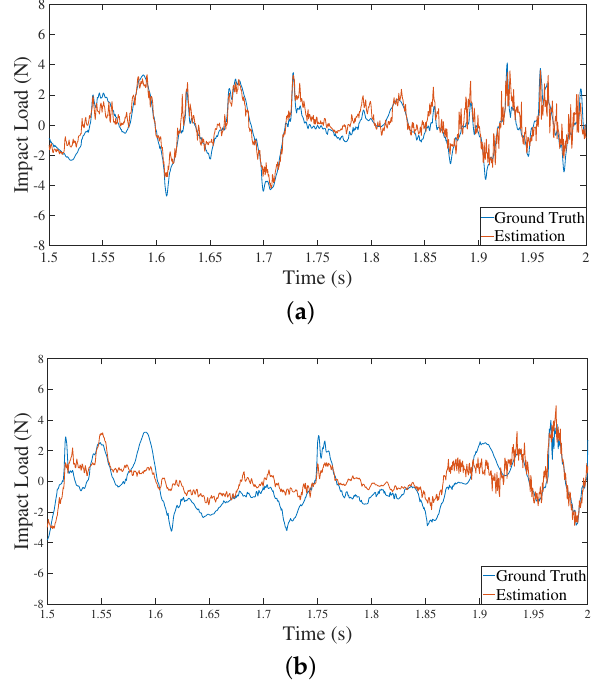
Figure 7. Comparisons between the identified random loads and the ground truths under different noise strengths. ( a ) Comparisons with respect to the ground truths (blue) at noise strength of 0% for the proposed method (red). ( b ) Comparisons with respect to the ground truths (blue) at noise strength of 40% for the proposed method (red).